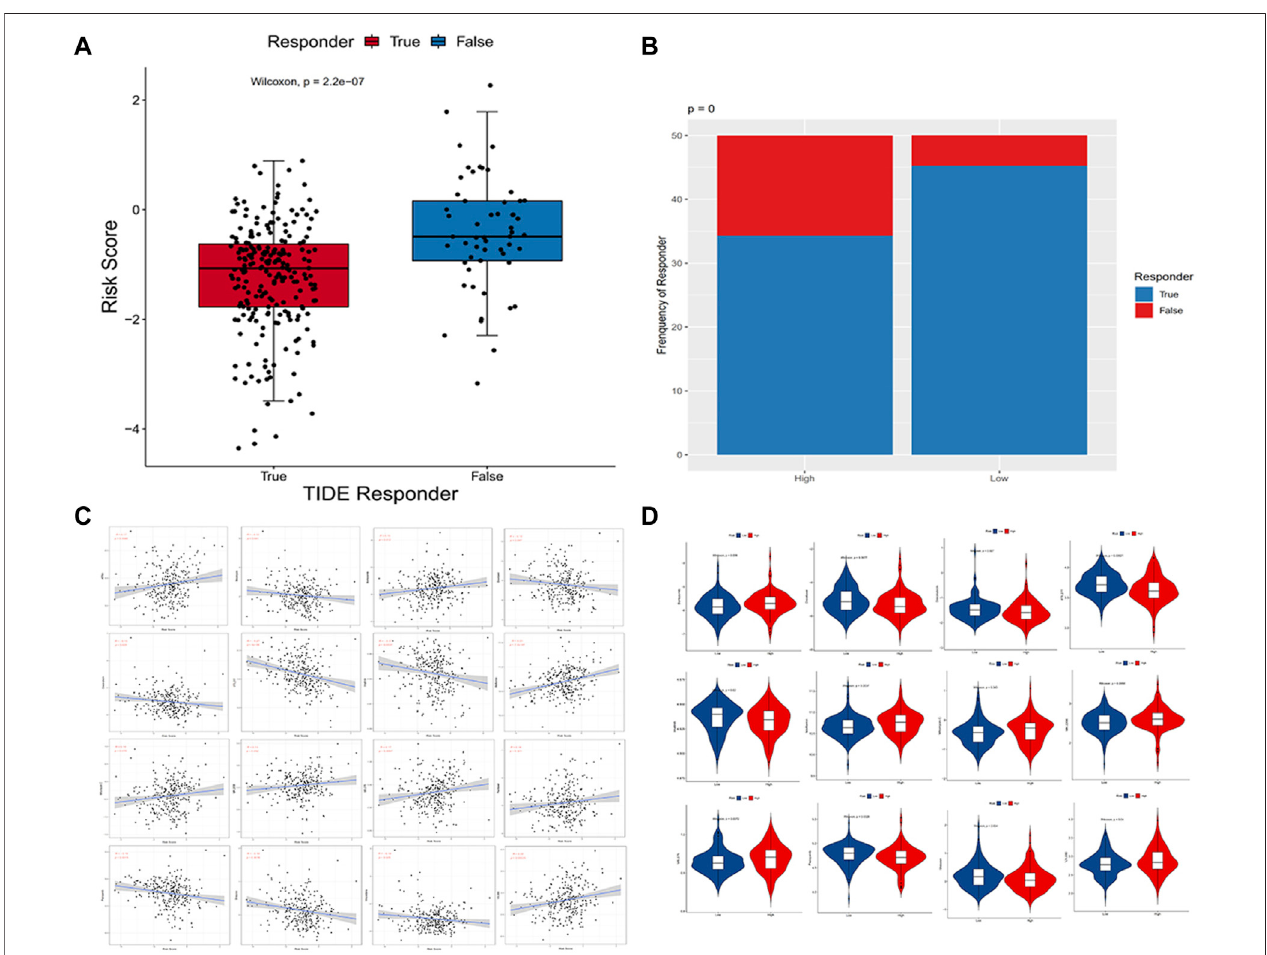
FIGURE9|(A,B) DistributionofimmunotherapeuticresponseindifferentgroupsbasedontheTIDEalgorithm.Wilcoxonrank-sumtestswereemployedtoanalyze contingencytablesforICIresponders; (C) Pointplotsexhibitedthecorrelationbetween16compoundsandtheestimatedIC50; (D) Violinplotsvisualizedthedifferences in the estimated IC50 between these two